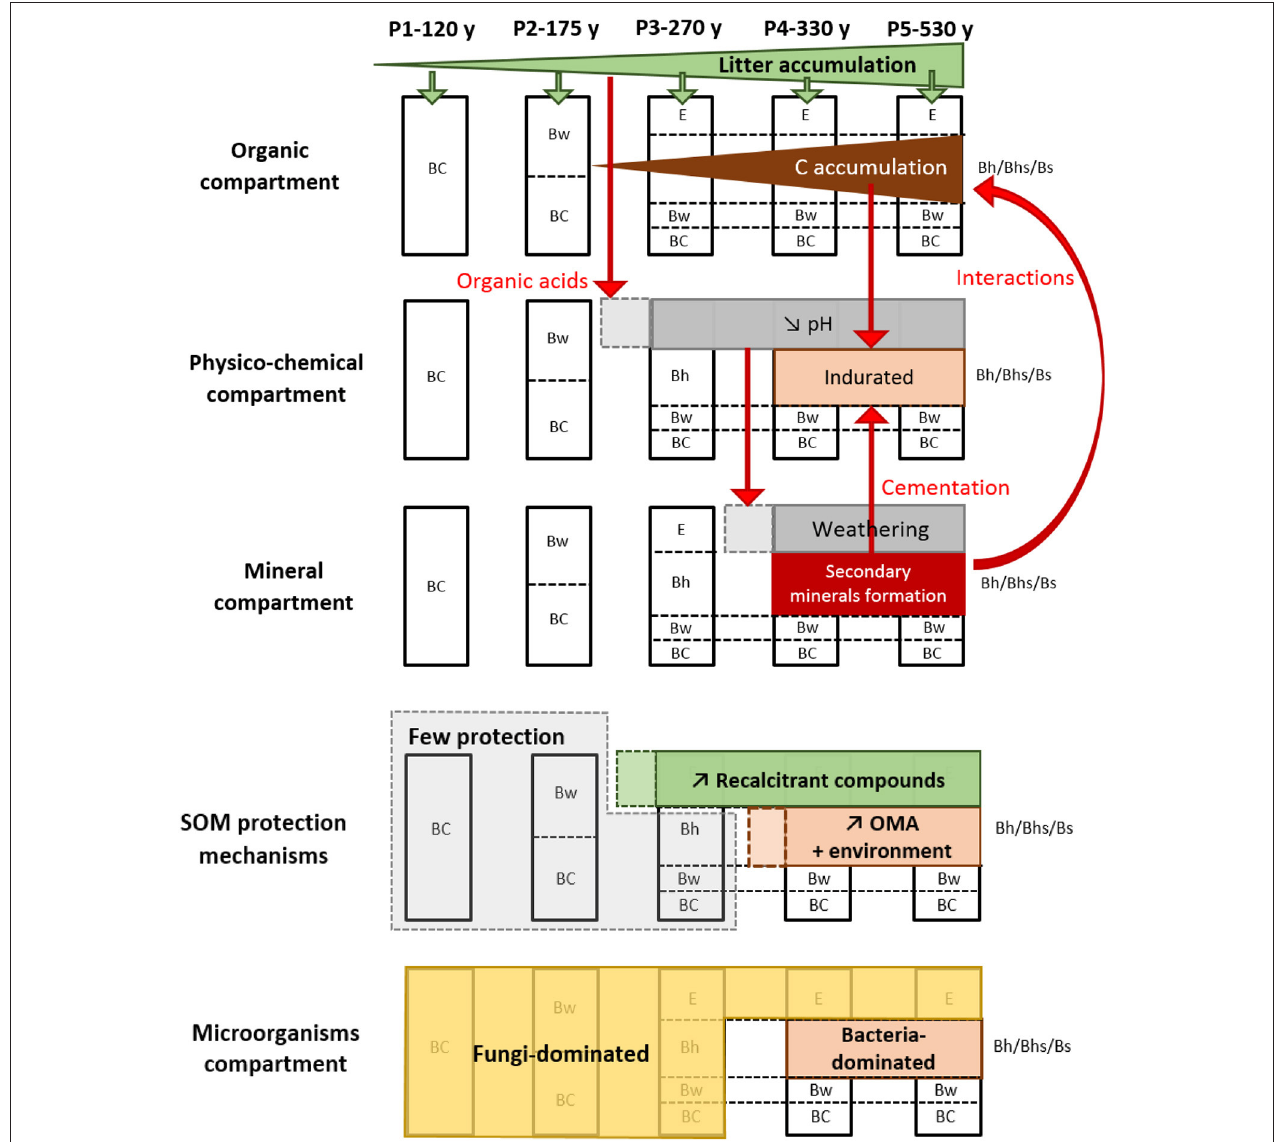
FIGURE 6 | Evolutions in the organic, physico-chemical and mineral compartments, resulting main SOM protection mechanisms and microorganism population, for the five Vancouver profiles of increasing age (P1-120 years, P2-170 years, P3-270 years, P4-330 years, and P5-530 years).